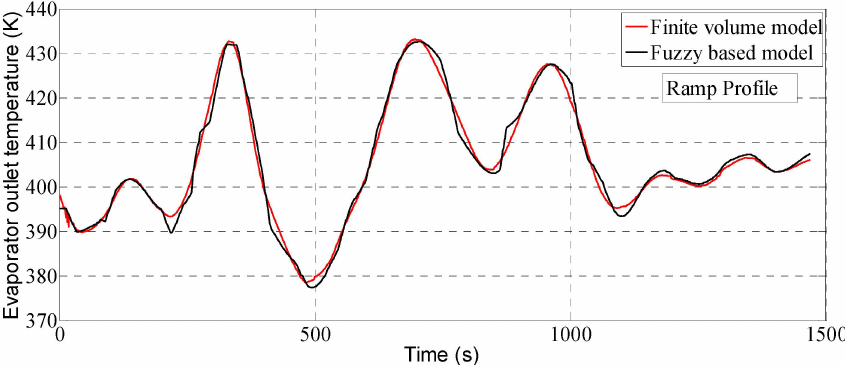
Figure 24. Prediction of the evaporator outlet temperature with respect to ramp profile.